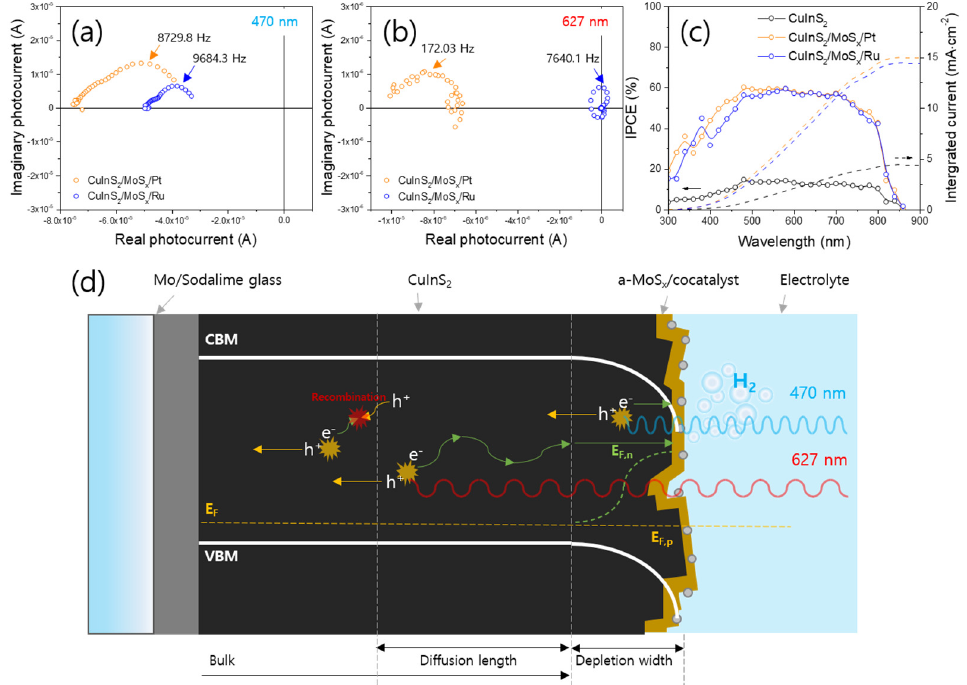
Figure 7. Effects of Ru and Pt cocatalysts on CuInS 2 /MoS x photocathodes, such as the improved transient time of electrons by the Ru cocatalysts. Intensity-modulated photocurrent spectroscopy results of CuInS 2 -based photocathodes under ( a ) 470 nm and ( b ) 627 nm LED light. ( c ) IPCE data of CuInS 2 -based photocathodes. ( d ) Schematic diagram of charge carrier transportation at CuInS 2 /MoS x /cocatalysts interfaces [35]. Reproduced from ref. [31] with permission from Elsevier.